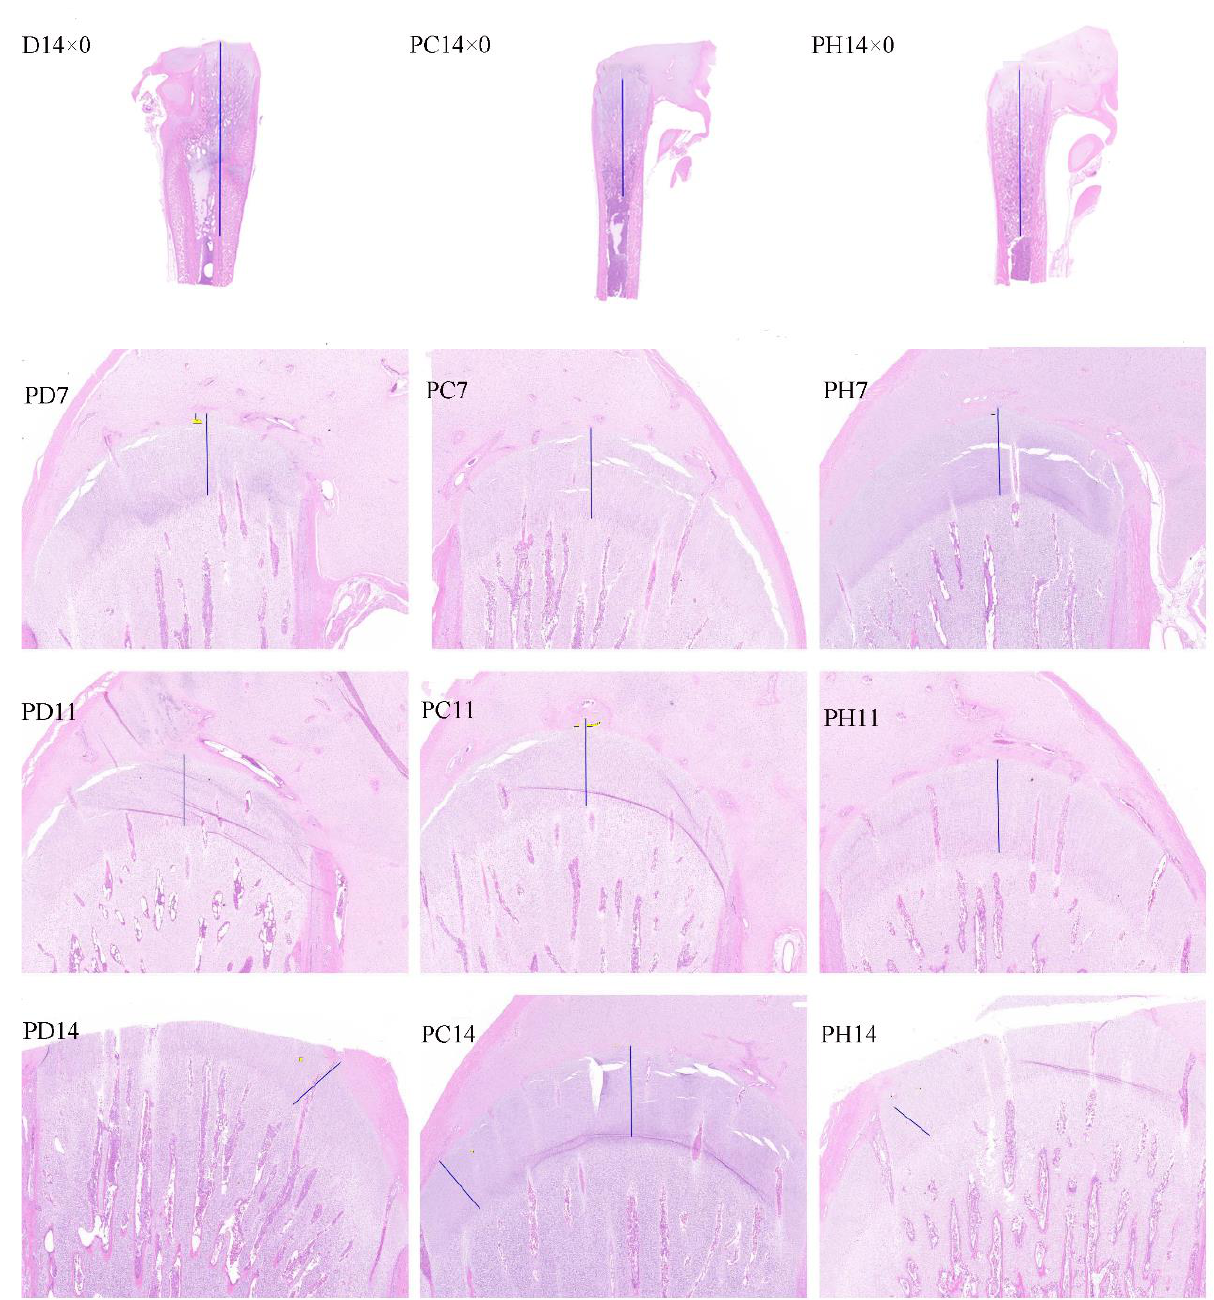
Figure A1. The effect of dietary phosphorus (P) deficiency and high P content on the morphology of tibia in goslings. 1 The goslings were fed, respectively, with a P deficiency (PD) diet, a control (PC) diet, and a high P content diet (PH). Samples were treated with H.E. staining. Numbers 4, 7, 11, and 14, respectively, refer to the accumulated days after feeding the above feeds by goslings; × 0, magnification × 0; other pictures, magnification × 2. Blue lines mark the length of the proliferative zone. Dietary P deficiency negatively affected the tibia development in goslings. The length of proliferative zones was reduced on days 7, 11, and 14 in the PD group, compared with PC and PH. The length of the hypertrophic zone was increased on day 14 in the PD group, compared with PC and PH.